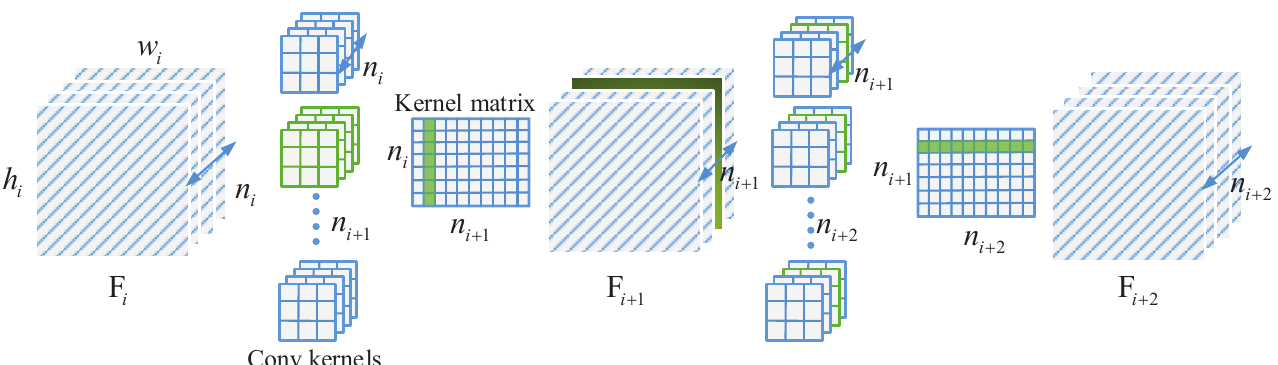
Figure 2. Pruning a channel results in the removal of both the corresponding filter in the previous layer and related convolution kernels in the next